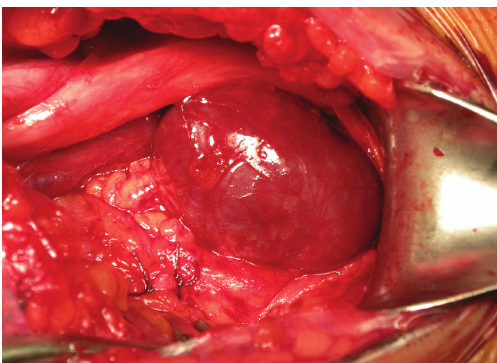
Figure 1: Intraoperative image shows a big popliteal vein